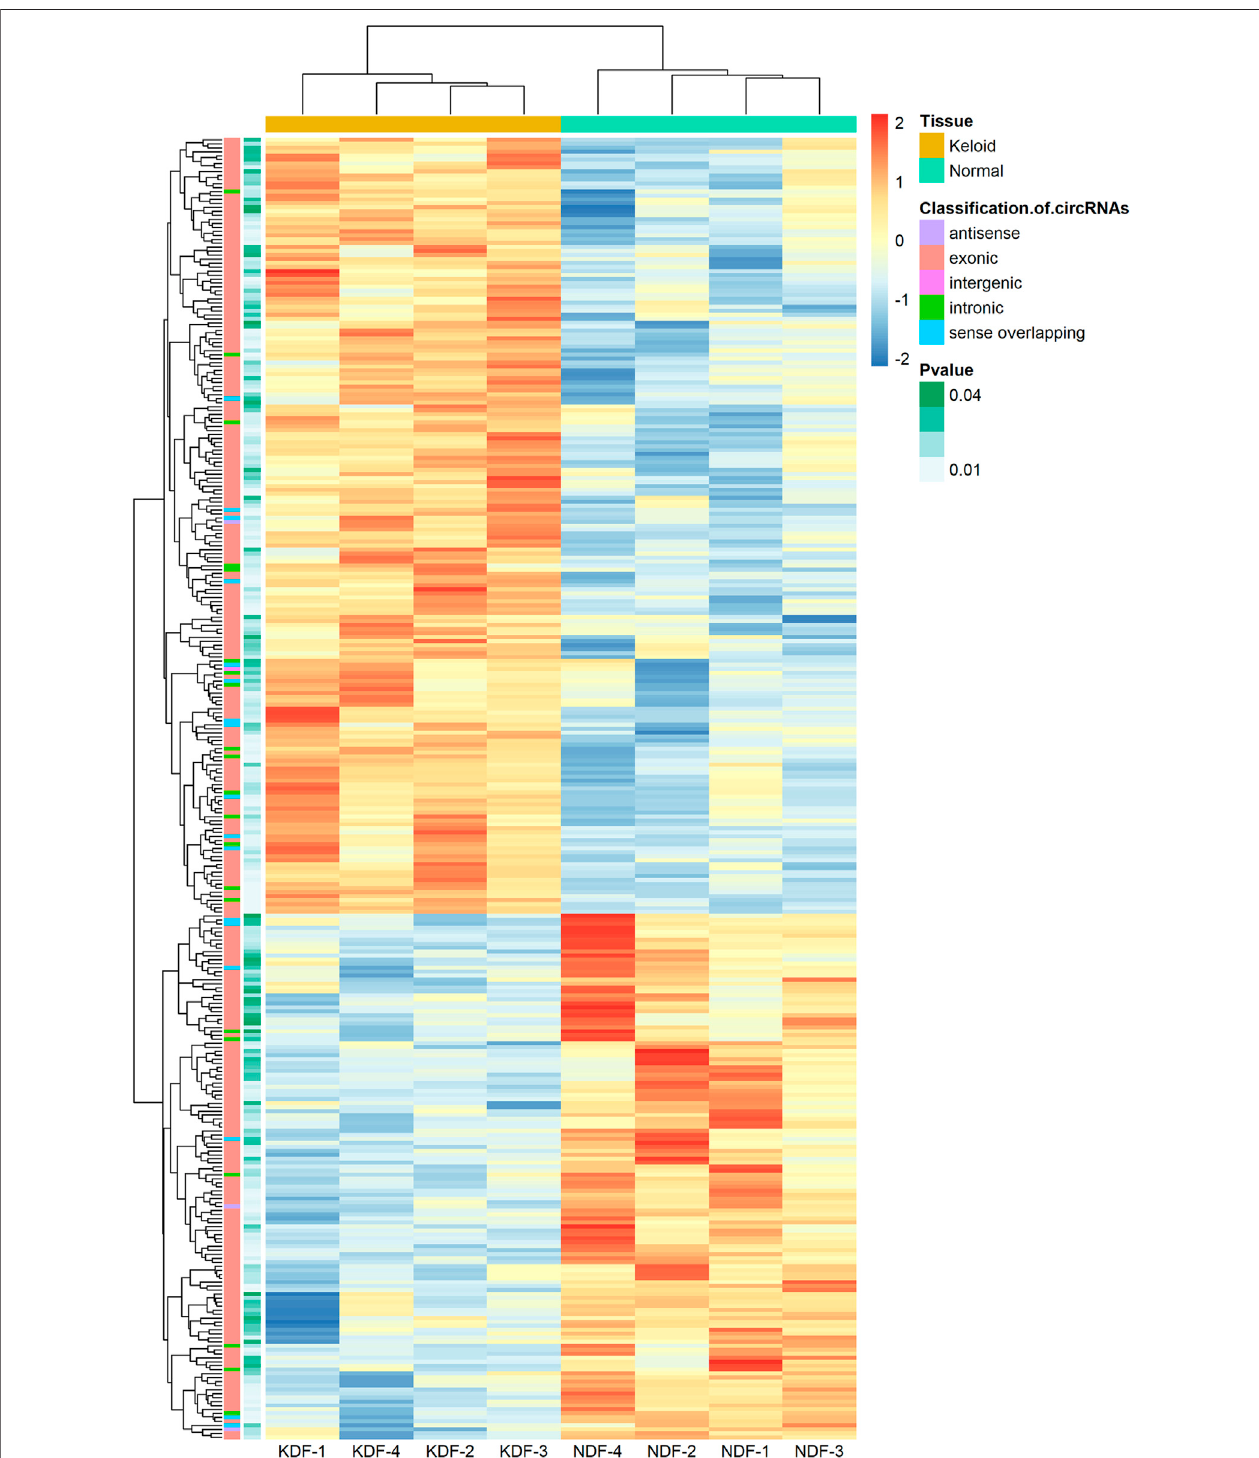
FIGURE 3 | Heatmap of circRNA pro fi les from the microarray data showing distinguishable circRNA expression patterns. Red and blue indicate high and low expression,respectively, andthecolorscalesrepresent expression values.Thecolumnsrepresentsamples,and therows represent circRNAs. ThetypeofcircRNAand p values of each analysis are shown in the fi rst and second columns, respectively.